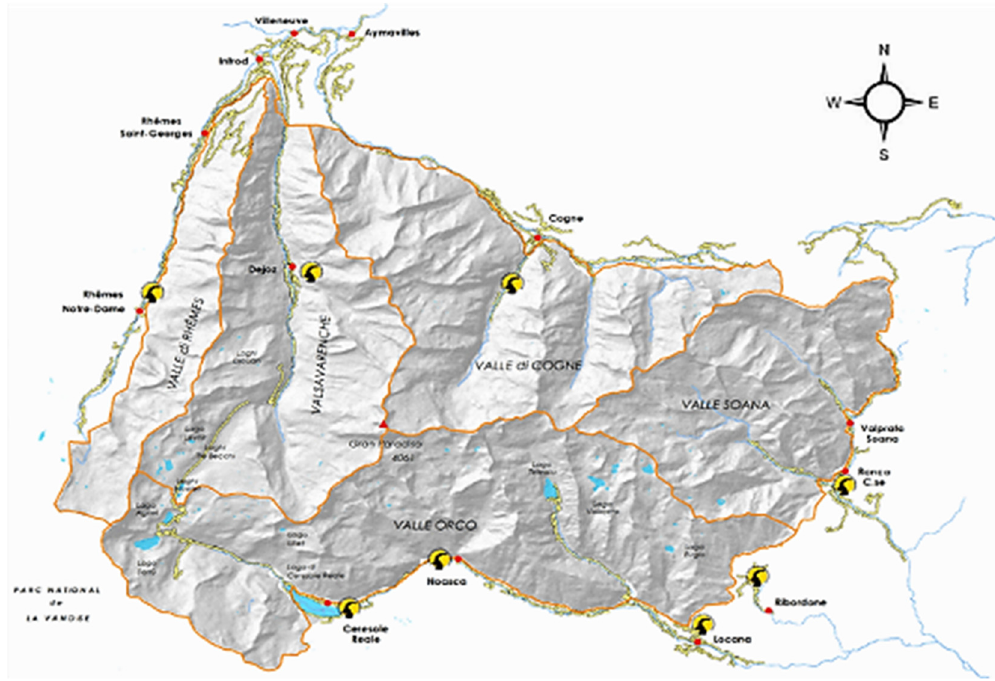
Figure 6. Map of the Gran Paradiso National Park .